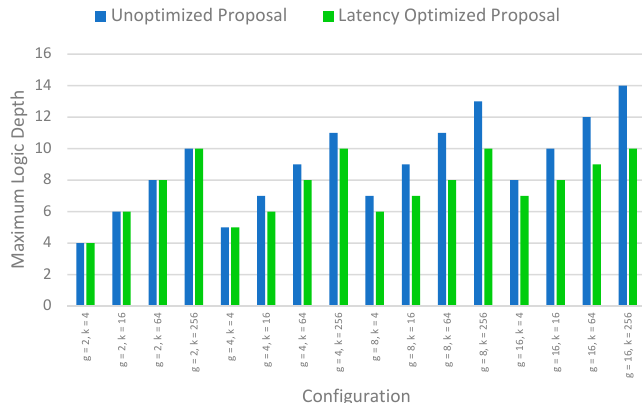
Figure 10. Comparison of maximum decoder logic depth for unoptimized proposal and latency optimized proposal.